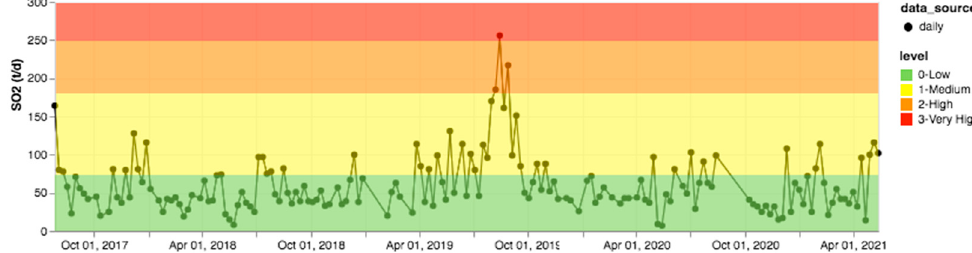
Figure 13. SO 2 flux time series for 2017–2021 with indication of activity level, extracted from LGS daily bulletins.